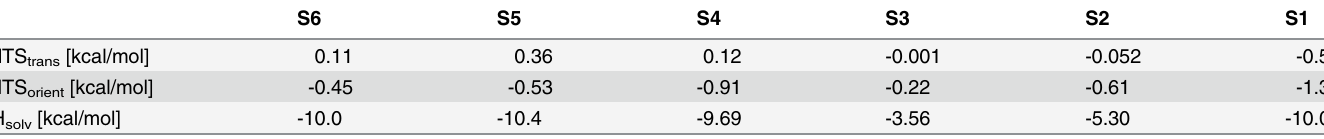
Table 2. Sub-pocket-wise water thermodynamics for holo simulations: dTS trans , dTS orient , H solv per water. The rigidity of sub-pocket S1 is reflected in a higher ordering of water molecules. Enthalpic interactions between solvent and solute are very similar within pockets S1, S4, S5, and